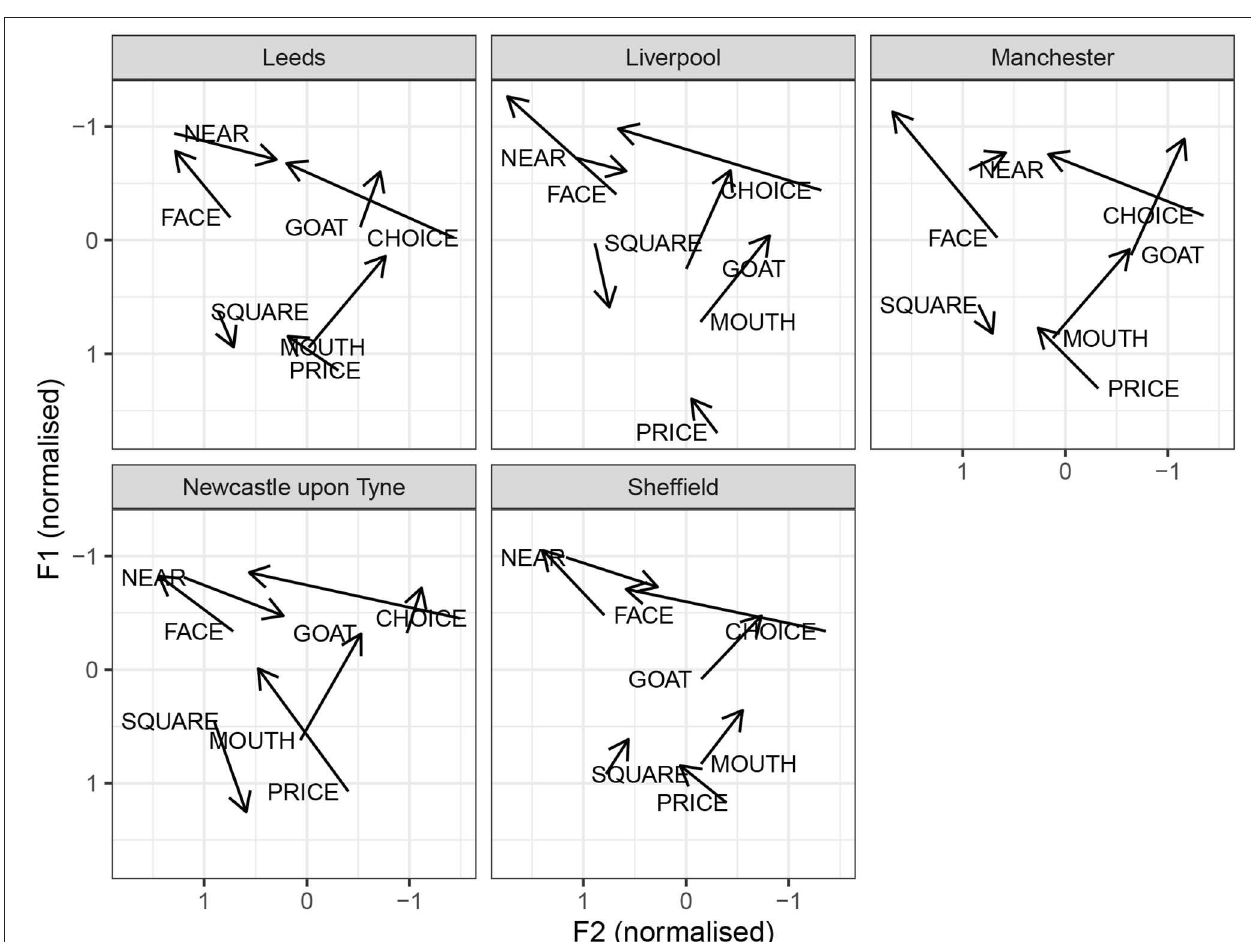
FIGURE 7 | By-city diphthong vowel